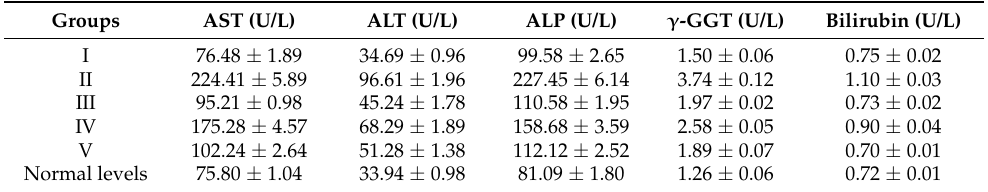
Table 6. Influence of LUT-SNEDDS (LSN1) and LUT suspension administrations on different biomark- ers of rat